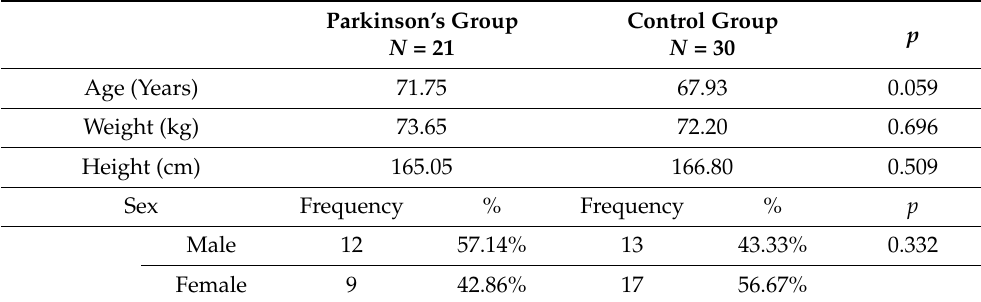
Table 1. Sociodemographic characteristics of the study population.